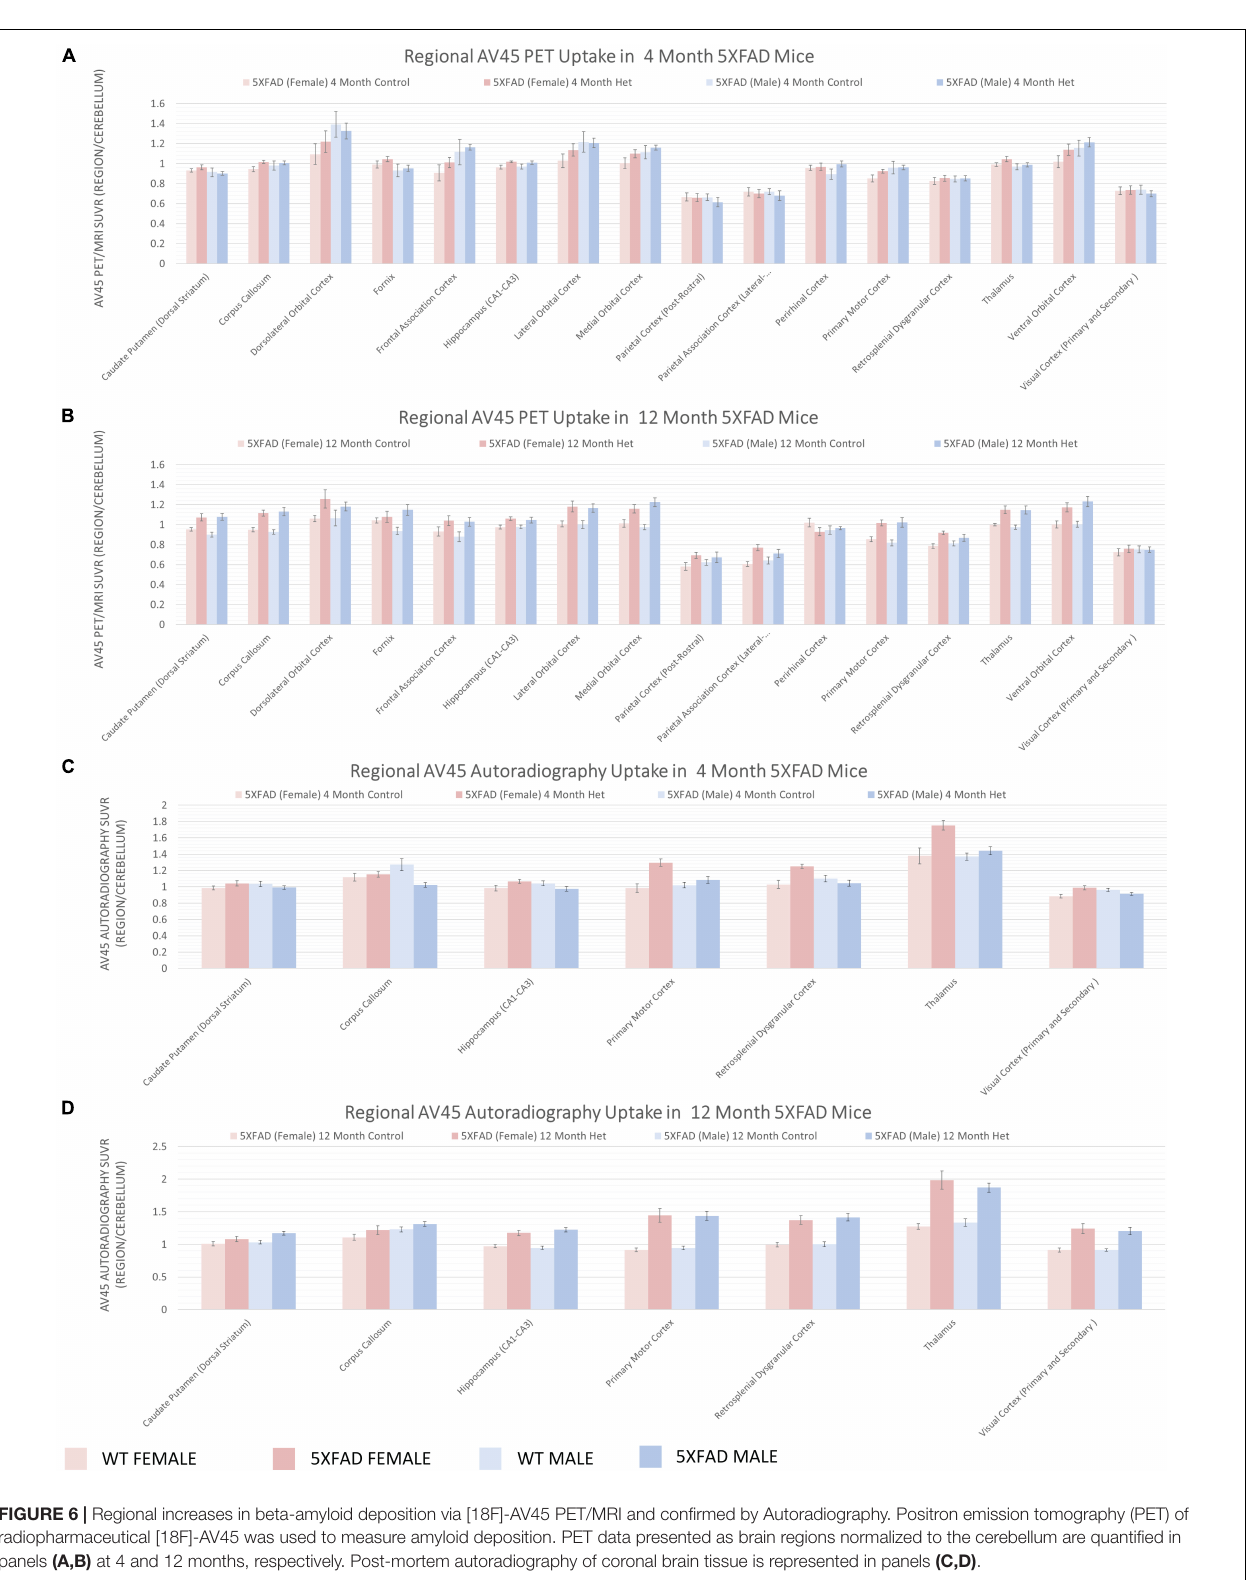
FIGURE 6 | Regional increases in beta-amyloid deposition via [18F]-AV45 PET/MRI and confirmed by Autoradiography. Positron emission tomography (PET) of radiopharmaceutical [18F]-AV45 was used to measure amyloid deposition. PET data presented as brain regions normalized to the cerebellum are quantified in panels (A,B) at 4 and 12 months, respectively. Post-mortem autoradiography of coronal brain tissue is represented in panels (C,D) .